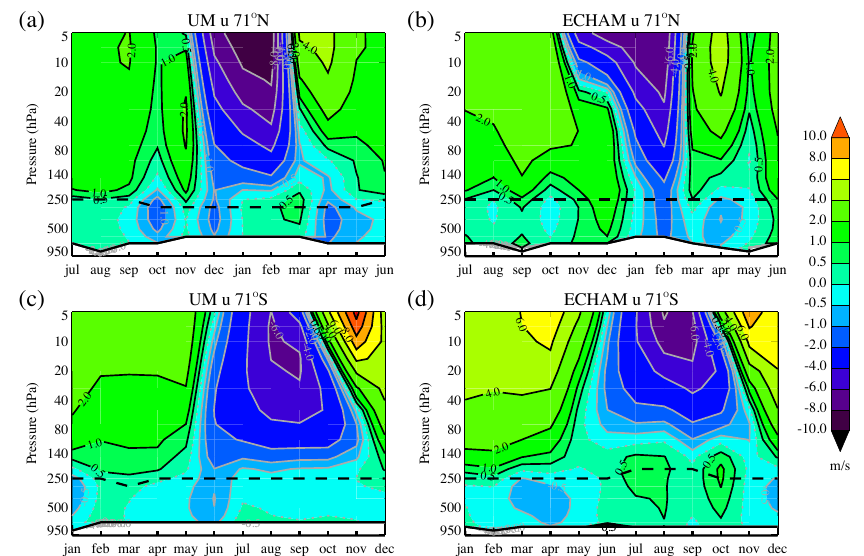
Fig. 11. Same as Fig. 10 but for the model wind response.